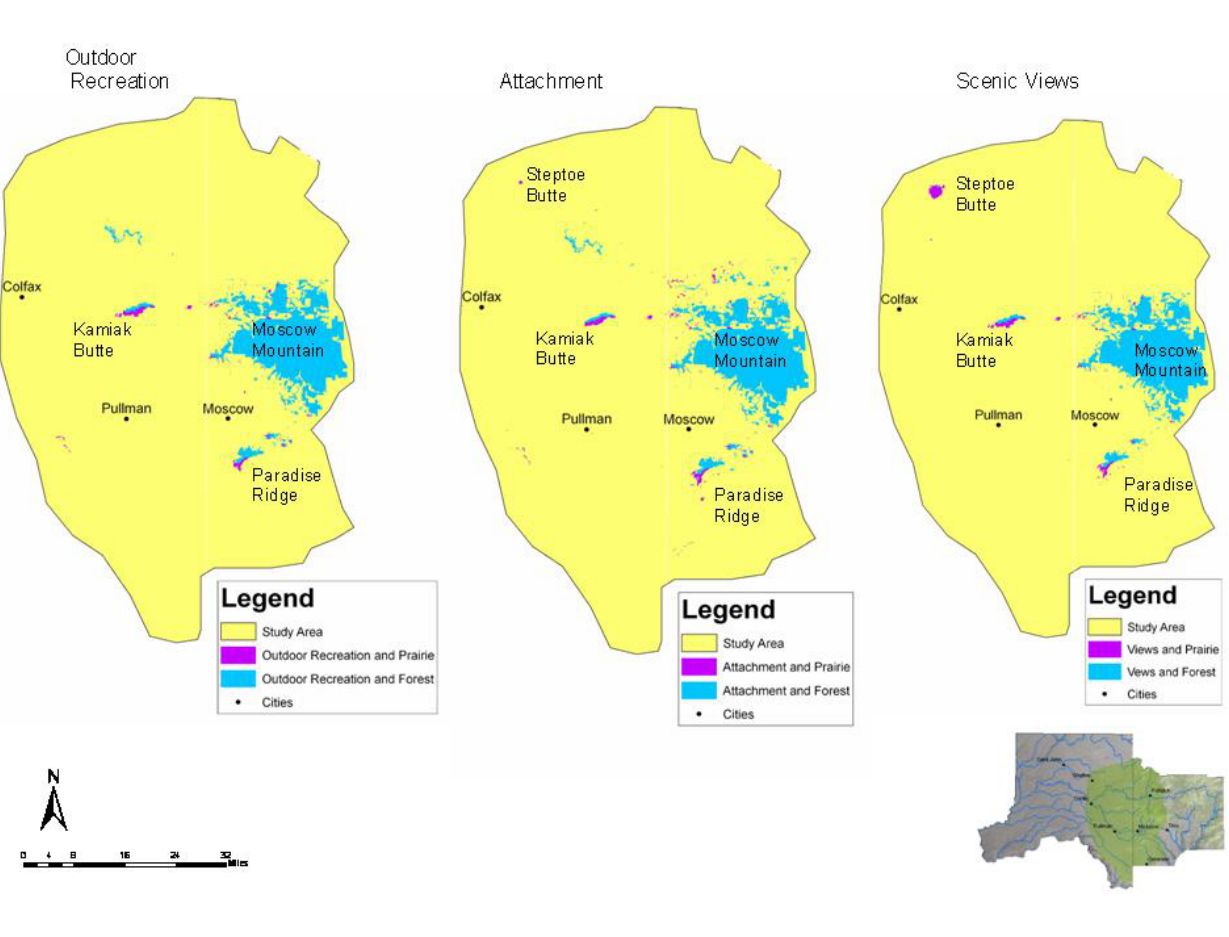
Fig. 3 . Spatial maps showing similarity in overlap between (A) outdoor recreation, (B) attachment, and (C) scenic views